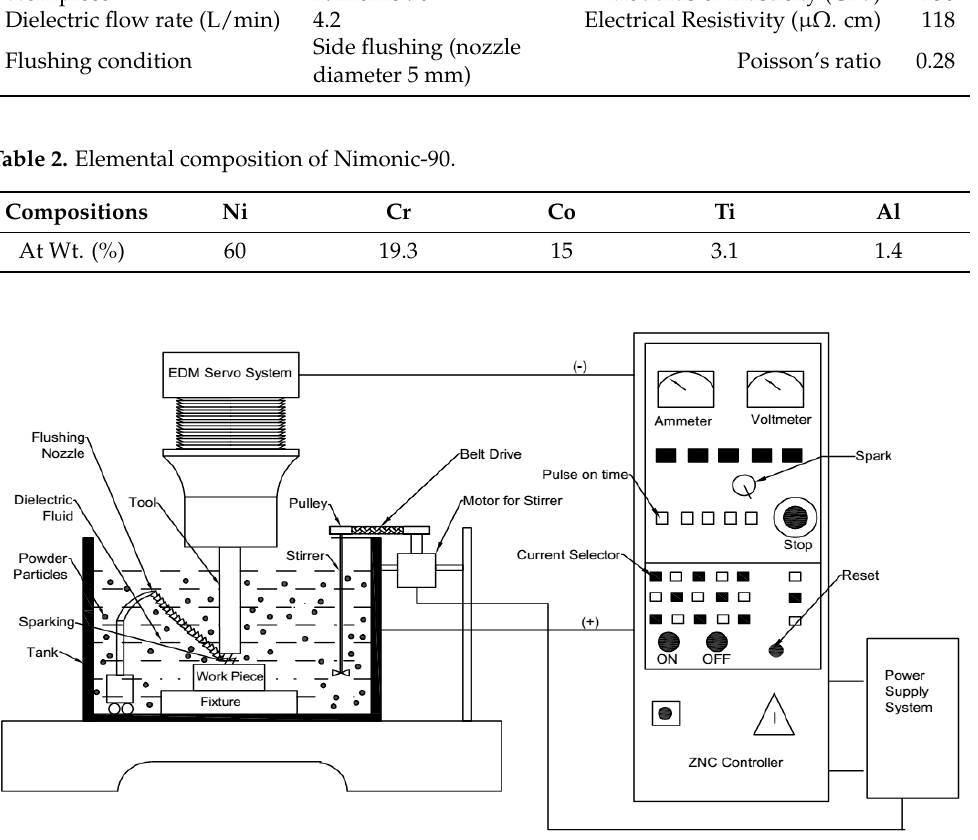
Figure 1. Schematic Diagram of Powder Mixed EDM Setup.